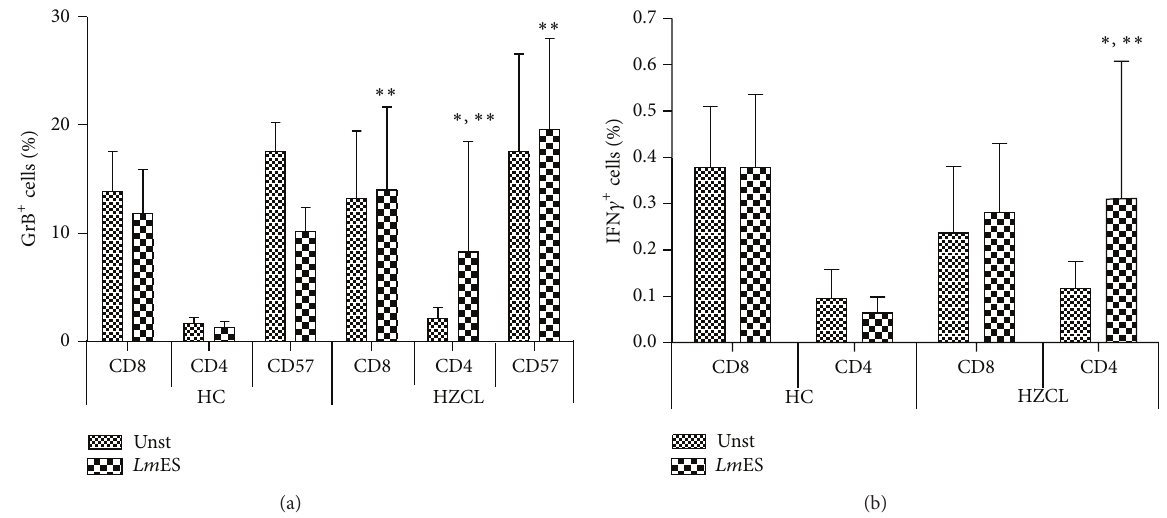
Figure 3: Phenotyping of cells producing GrB and IFN- 𝛾 . Percentage of cells positive for GrB (a) or IFN- 𝛾 (b) analyzed ex-vivo in PBMCs of HZCLorHC.ResultsareshownaspercentagesofpositivecellsinsidetheCD3 + Tcellsgate.Resultsareexpressedasthemean ± standarderror of the mean of levels. Statistical analysis: ∗ 𝑃 < 0.05 , when comparing the stimulated cells to the unstimulated cells (Unst) and ∗∗ 𝑃 < 0.05 , when comparing HZCL to